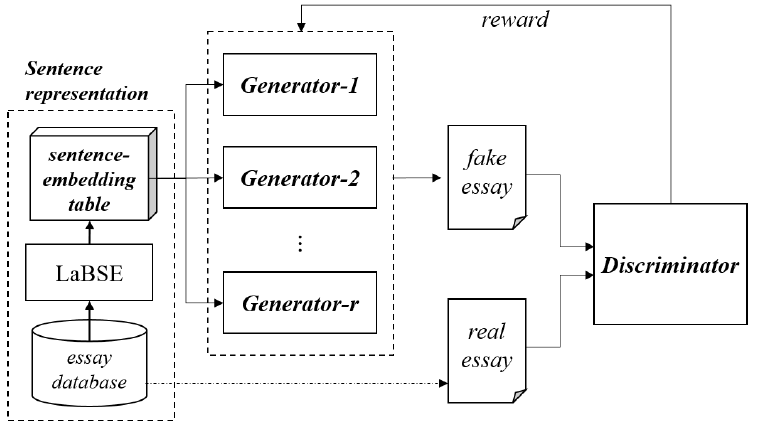
Figure 1. The overall architecture of